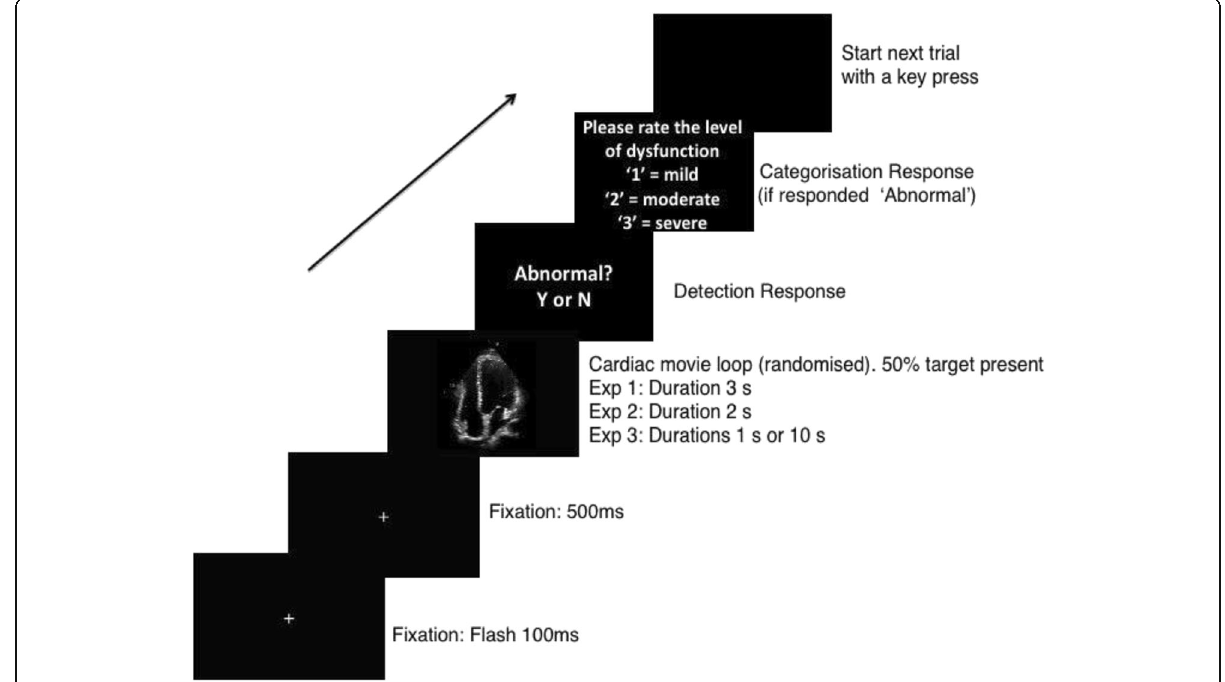
Fig. 2 Example of an experimental trial for diagnostic performance shown to the participants in three experiments. Trials began with a fixation cross followed by the cardiac movie and a response screen for detection. The subsequent categorization screen was displayed if the participant responded “ Yes ” for abnormal. Note: Movie durations were as follows: Experiment 1: 3 s, Experiment 2: 2 s, Experiment 3: Either 1 s or 10